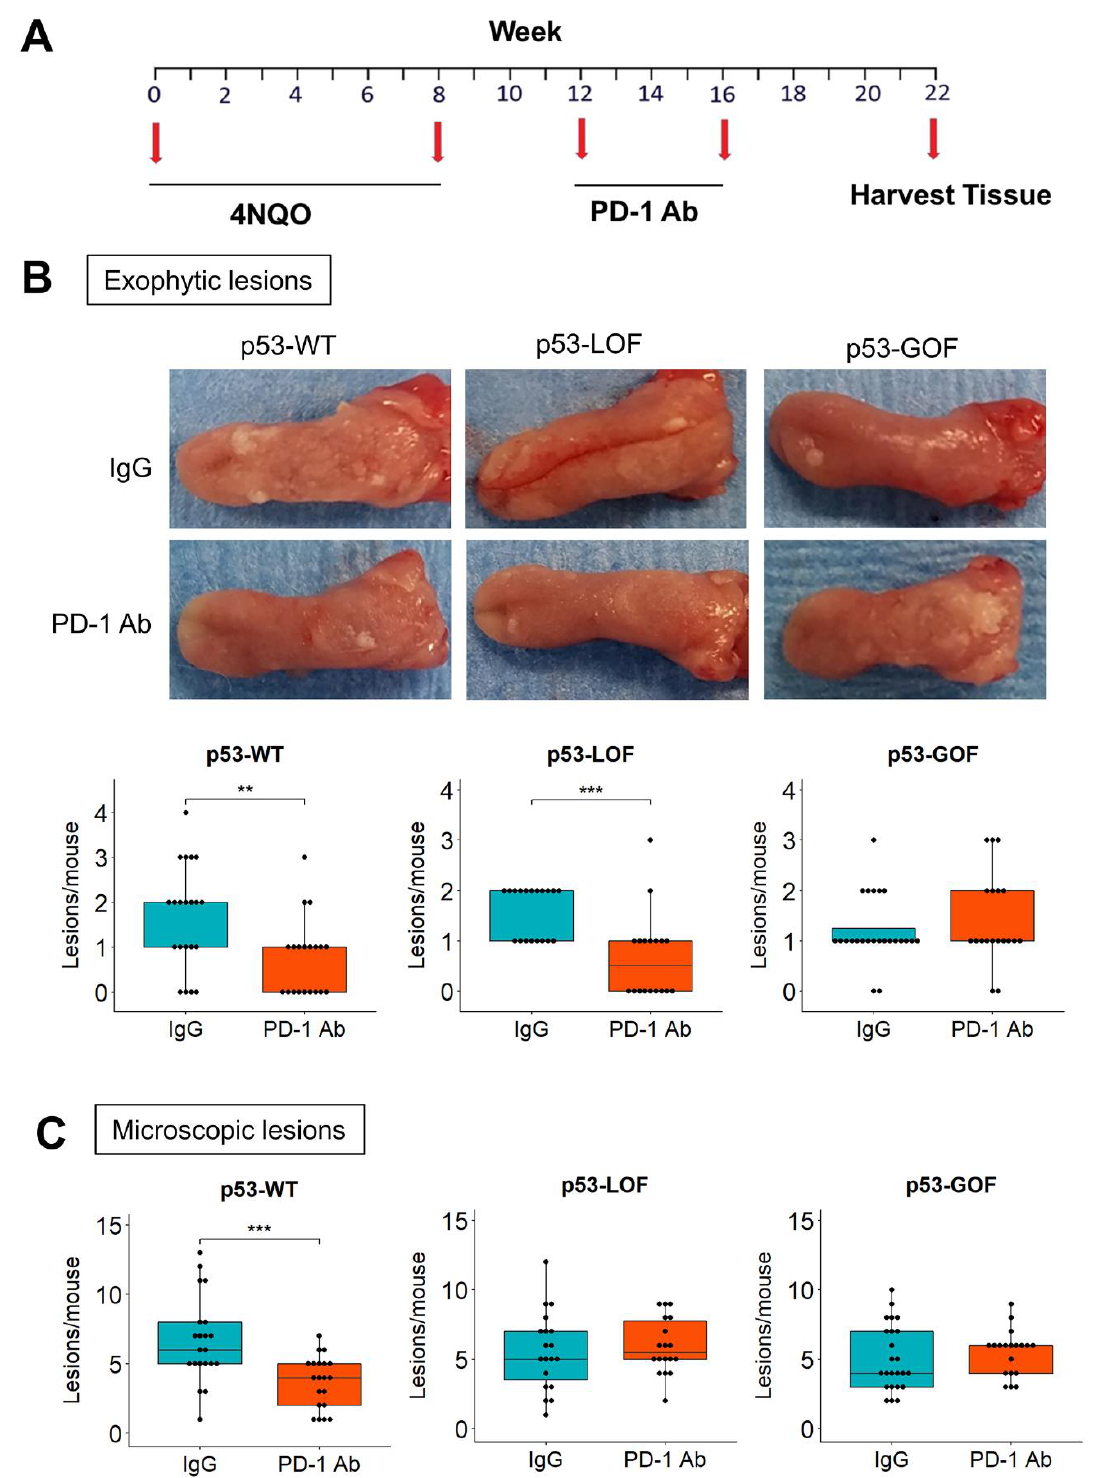
Figure 4. Epithelial mutant p53 R172H blocks the potential of anti-PD-1 to prevent oral tumor development. ( A ) Schedule of the preclinical study for anti-PD-1 oral cancer immunoprevention. ( B ) Gross appearance of the 4NQO-induced exophytic lesions that developed in the tongues of mice treated with control IgG or anti-PD-1. Quantification of the lesions, determined by visual examination, is shown on the bottom panels. ( C ) Quantification of the 4NQO-induced microscopic lesions on histological sections of the tongues. ** p < 0.01, *** p < 0.001.